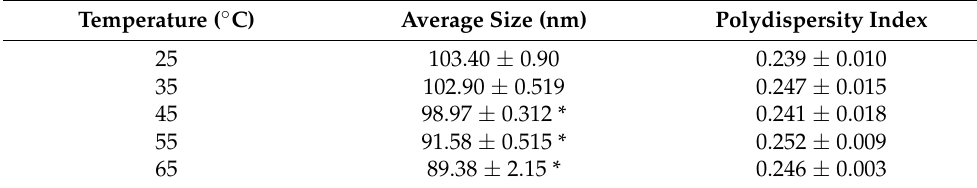
Table 3. Diameter (mm) of A. fl avus colonies in the presence of EO and NE at 48, 72, and 96 h.